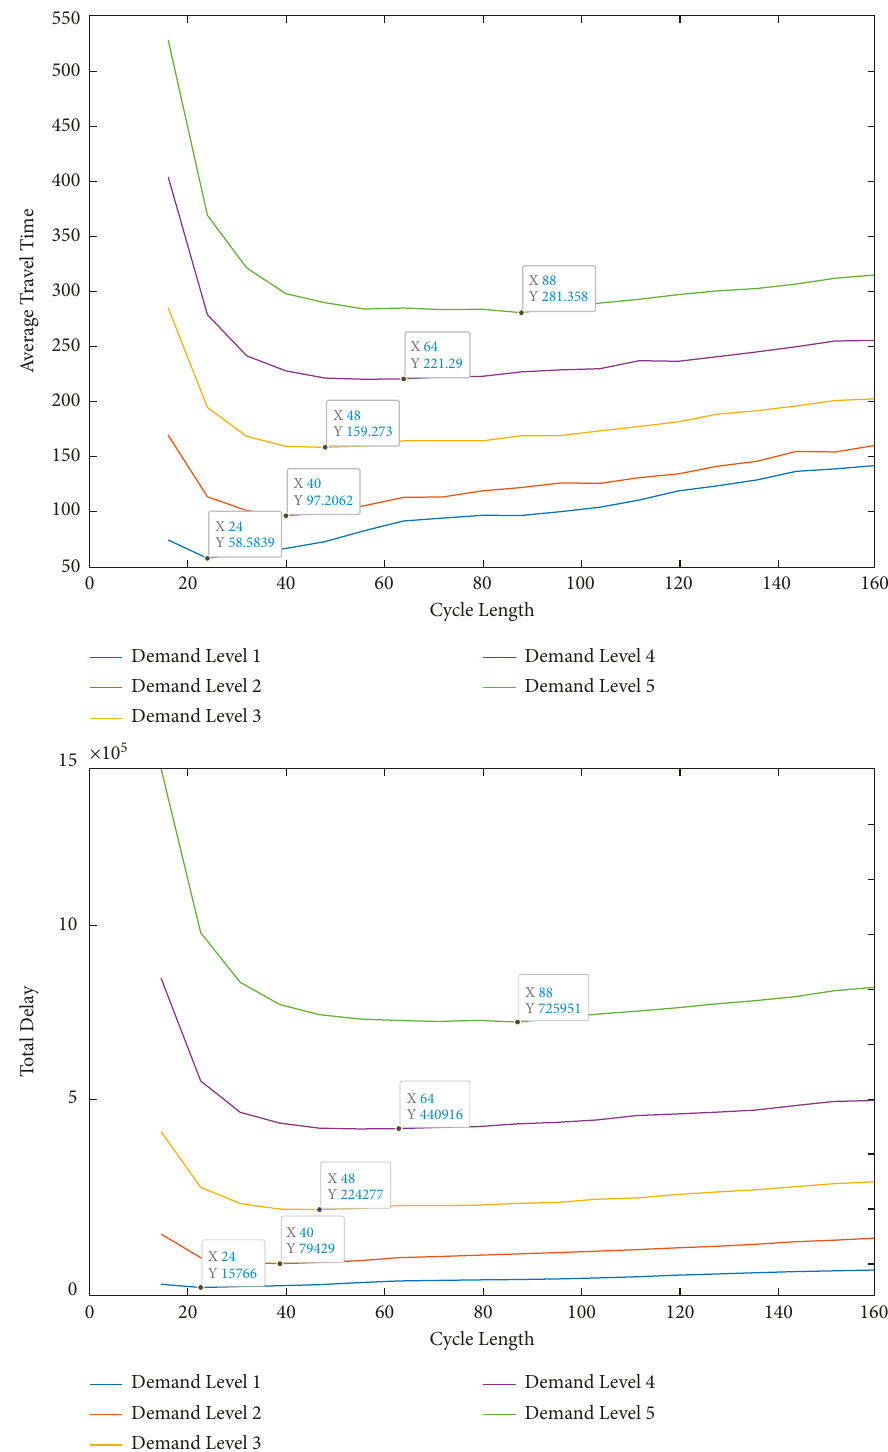
Figure 10: ATT and TTD under different demand